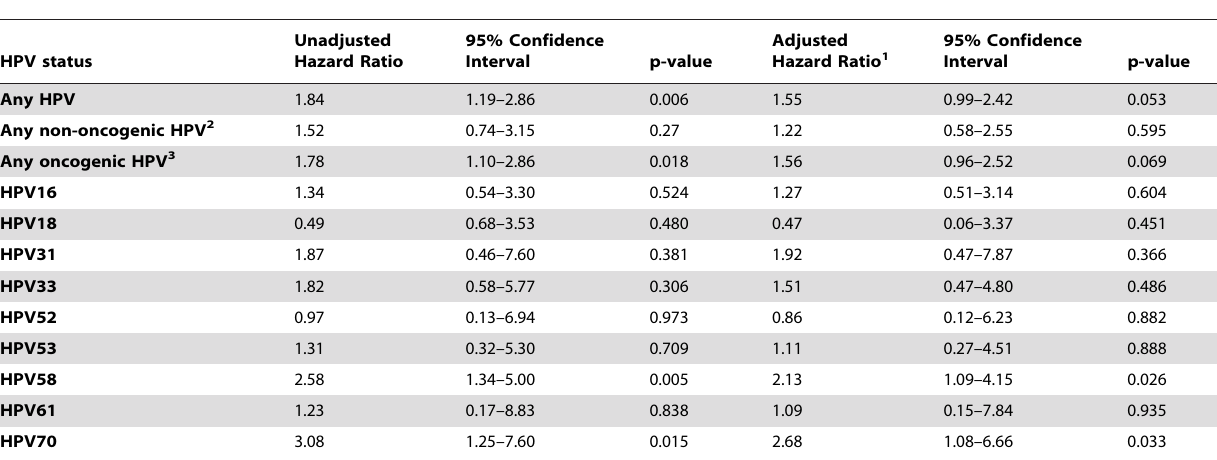
Table 2. Prevalent HPV infection as a predictor of HIV